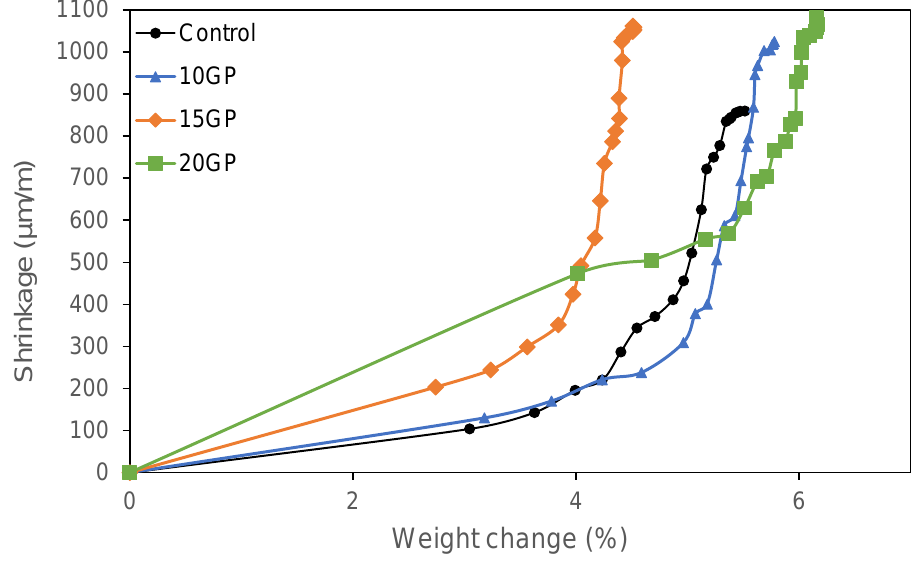
Figure 10. Total shrinkage as a function of weight loss.